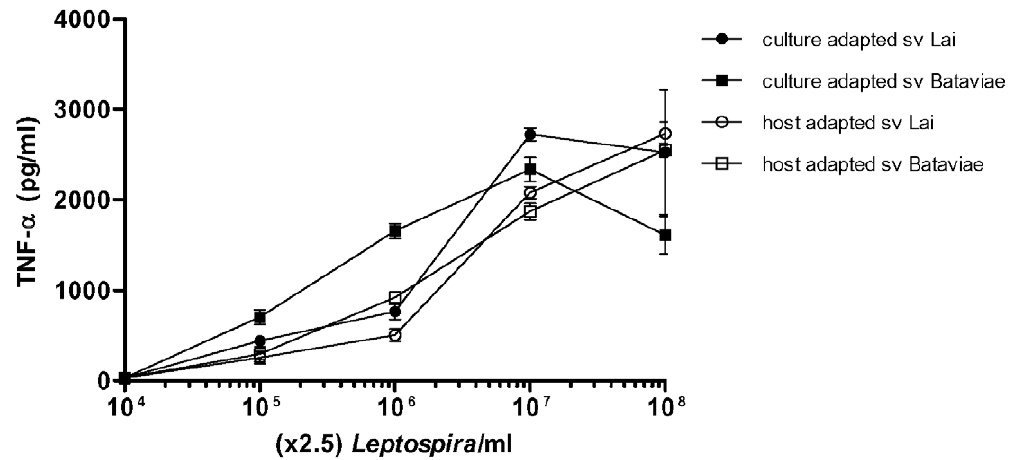
Figure 3. Activation of PMBC with live leptospires. Cells were stimulated for 6 h with varying concentrations of leptospires. TNF- a concentrations were measured from cell culture supernatants. Data represent the mean values and error bars represent the standard deviation (SD) of the mean. The response of all blanks was below the baseline and therefore is not shown.